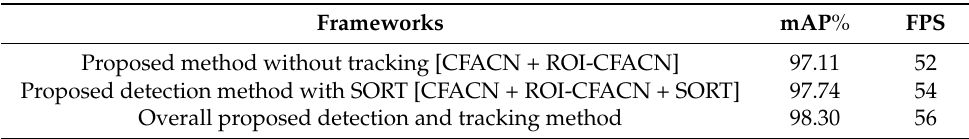
Table 6. The comparison results of the overall proposed method with detection standalone (without tracking algorithm) and with simple online real-time tracking (SORT) (including the proposed detector as detector algorithm and SORT for